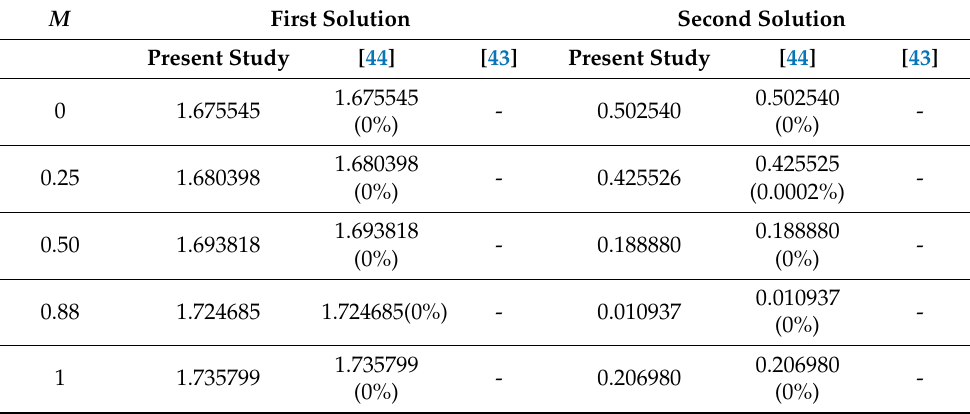
Table 4. Validation of − θ (cid:48) ( 0 ) when φ 1 = φ 2 = Q = 0, β = − 1, and α = 1, with various M .